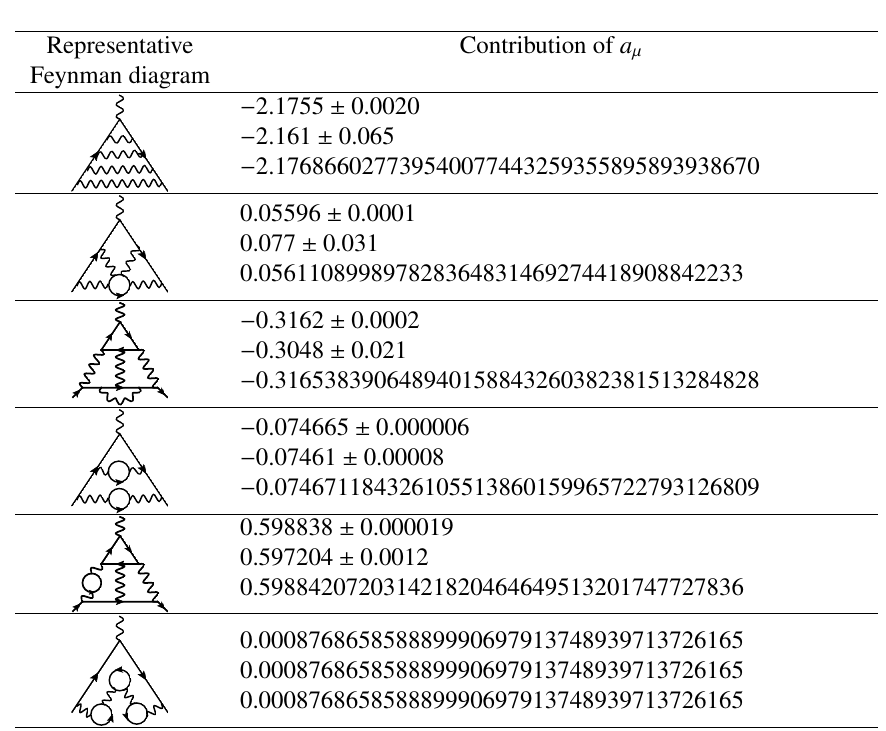
Table 1. The three numbers given in each row (from top to bottom) are taken from [33], this work, and [24],